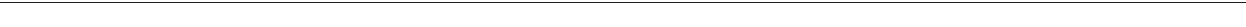
Fig. 2 Phosphorylation of ULK1 does not affect the ULLk1 and ATG13 complex and its kinase activity. a Flag-ATG13 was transfected with Myc-ULK1 WT, S423A and S423D into HEK293T cells for 24 h. The IPs were analyzed with Myc antibody. The densities of ATG13 were quanti fi ed with image J and showed in the bottom panel. b HA-FIP200 was transfected with Flag-ULK1 WT, S423A, and S423D into HEK293T cells for 24 h. IP was performed with Myc antibody and analyzed with HA antibody. The densities of Fip200 were quanti fi ed and showed in the bottom panel. c Flag-BECN1 was transfected with Myc-ULK1 WT, S423A, and S423D or Myc-Control into HEK293T cells for 24 h. IP was performed with Myc antibody and analyzed with Flag antibody. The densities of BECN1 were quanti fi ed and showed in the bottom panel. d IP of ULK1 complex partners by Myc-ULK1 variants transfected into HEK293T cells for 24 h was determined with ATG13, Fip200, BECN1 antibodies. The densities of ATG13, Fip200, and BECN1 are quanti fi ed and showed in the right panel. e ULK1, PKC α and mTORC1 activities were analyzed by WB after Myc-ULK1 WT and mutants were transfected into HeLa cells for 24 h. The densities of p-ATG13, p-BECN1, and p-ULK1 S757 are quanti fi ed and showed in the right panel. f HeLa cells were treated with different concentrations of PKC inhibitor GÖ6983 for 4 h. Lysates were analyzed with the indicated antibodies. g The densities of p-ATG13, p-BECN1, p-ULK1 S757, and p-mTORC1 were quanti fi ed from f . Statistical signi fi cance was measured via unpaired and two-tailed Student ’ s t -tests and is presented as follows: NS: no signi fi cance; * p < 0.05, ** p < 0.01, and *** p < 0.001. All error bars indicate SEM. Bars indicate mean ± SEM of triplicate samples. L-GÖ6983: low concentration, IC50; H-GÖ6983: high concentration, 5*IC50. WCL: whole-cell